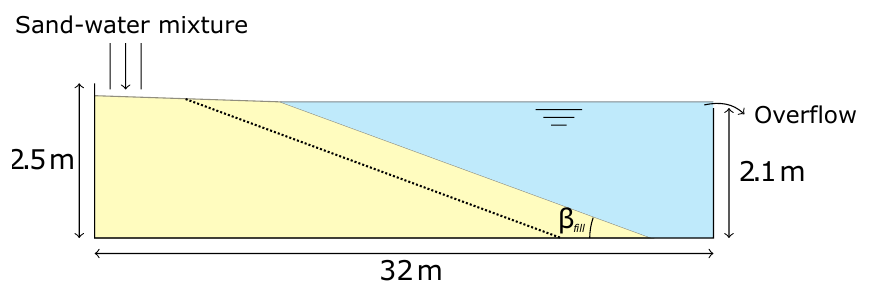
Figure 3. Steady slope angle, β fill , produced in an experimental run by Mastbergen et al.